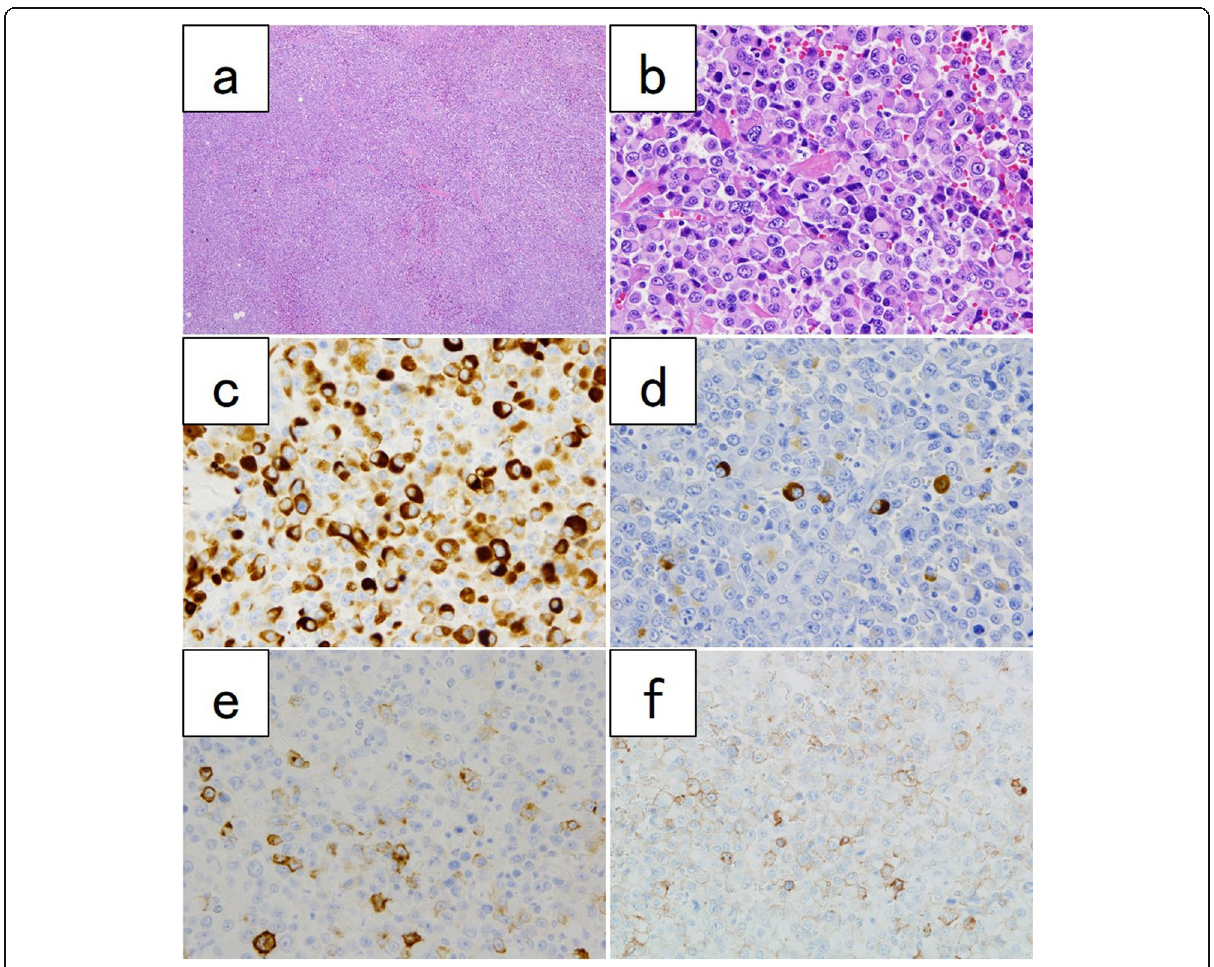
Fig. 3 Histological and immunohistochemical studies. Hematoxylin and eosin staining of tumor cells with rhabdoid cells ( a , × 40, b × 400). AE1/